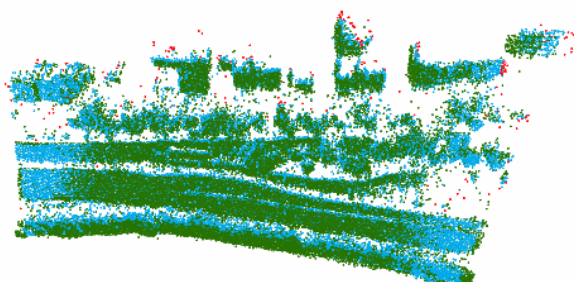
Figure 5. Overview of multispectral point cloud data